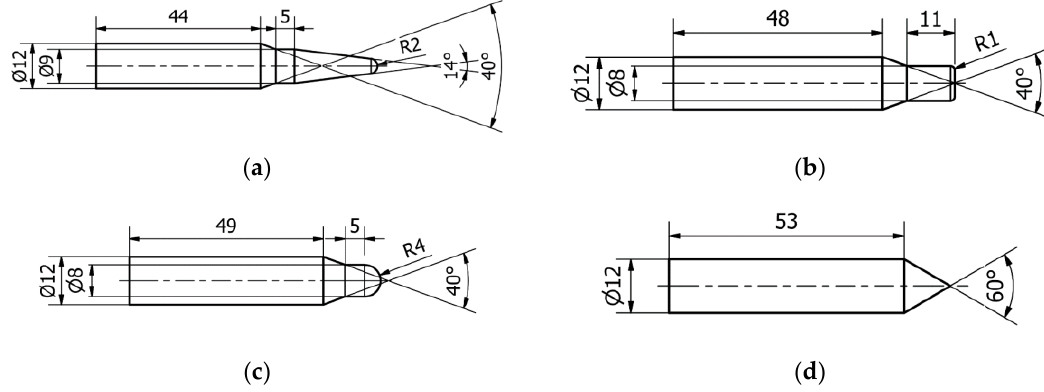
Figure A1. Geometries of developed strikers: ( a ) ogival, ( b ) blunt, ( c ) hemispherical, ( d ) conical.